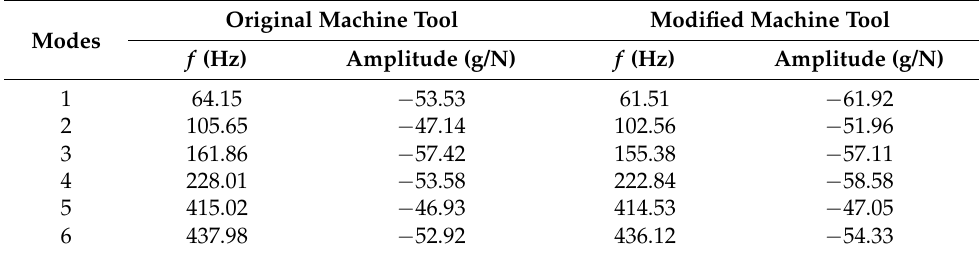
Figure 9. Comparison of FRF before and after modification of swing head. Table 3. Comparison of dynamics before and after modification of spindle head. Table 3. Comparison of dynamics before and after modification of spindle